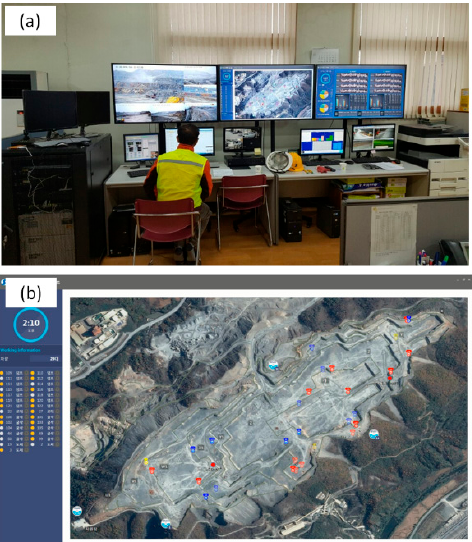
Figure 13. An open-pit mine in South Korea with a wireless communications system for fleet management of mine equipment. ( a ) Control center. ( b ) Main dashboard.